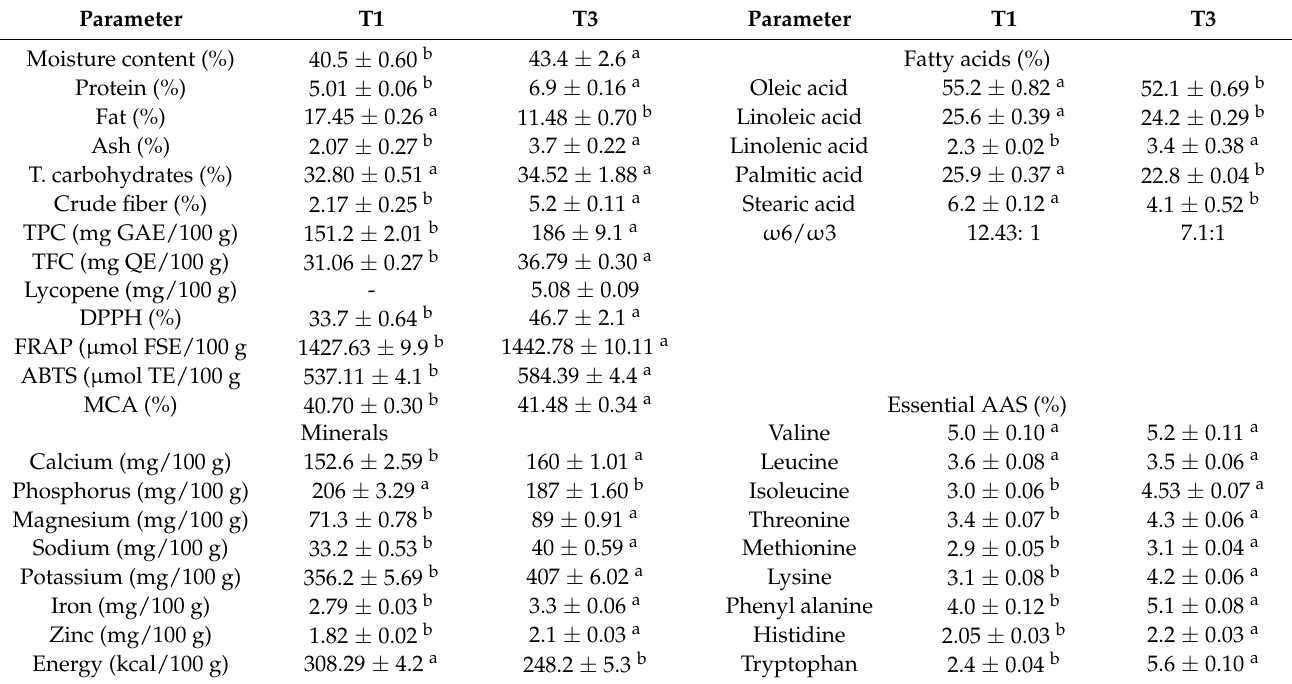
Table 3. Nutritional profile of ready-to-cook gluten-free snack (T1 (control) and